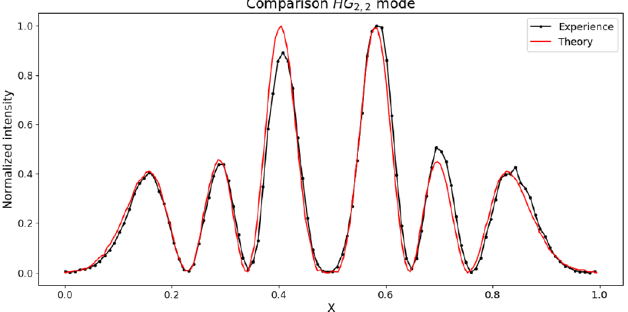
Fig. 10. Cut of the intensity profile of the mode LG 2 , 2 in black obtained experimentally and in red as predicted by the theory. The calculated RMS error is 0.46%.